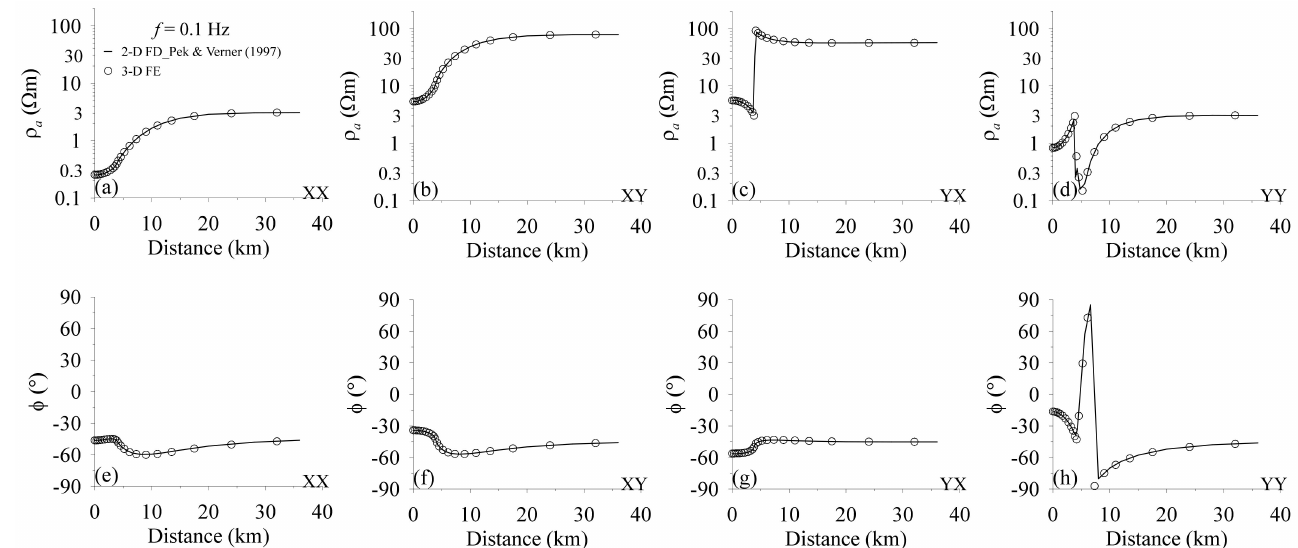
Figure 3. Comparison between our resistivities and phases with the 2-D FD results of Pek and Verner [15] using the laterally inhomogeneous and anisotropic dyke model of Reddy and Rankin [20]. The solid line denotes the results of Pek and Verner [15], and circles show the results of this study. The frequency is 0.1 Hz. ( a – d ) are apparent resistivities, and ( e – h ) are phases corresponding to XX, XY, YX, and YY modes,